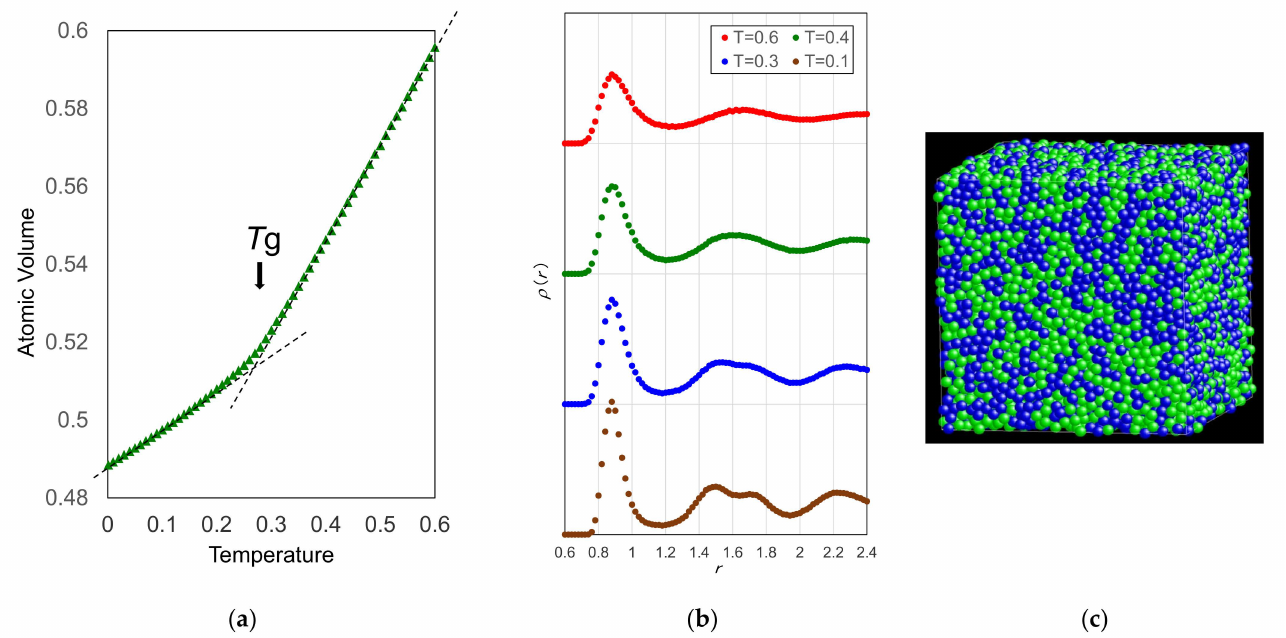
Figure 2. ( a ) Temperature dependence of the atomic volume in a middle-cooling process of the r BB = 0.9 A 50 B 50 system. ( b ) Radial distribution functions at T = 0.6, 0.4, 0.3, and 0.1. ( c ) Atomic configuration of an as-quenched state at T = 0.001, where the green and blue spheres denote the A and B atoms,